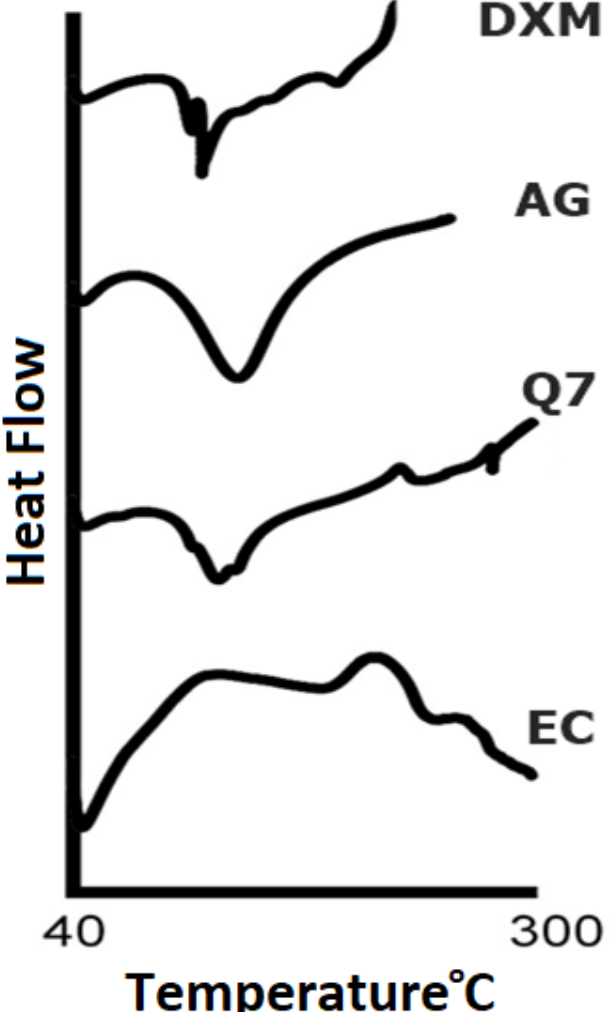
Figure 2. DSC thermograms of DXM and polymer and physical mixtures .